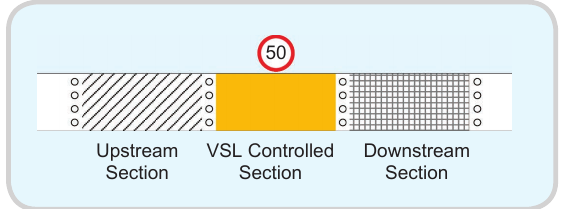
Figure 6. Determination of state set in the RL agent